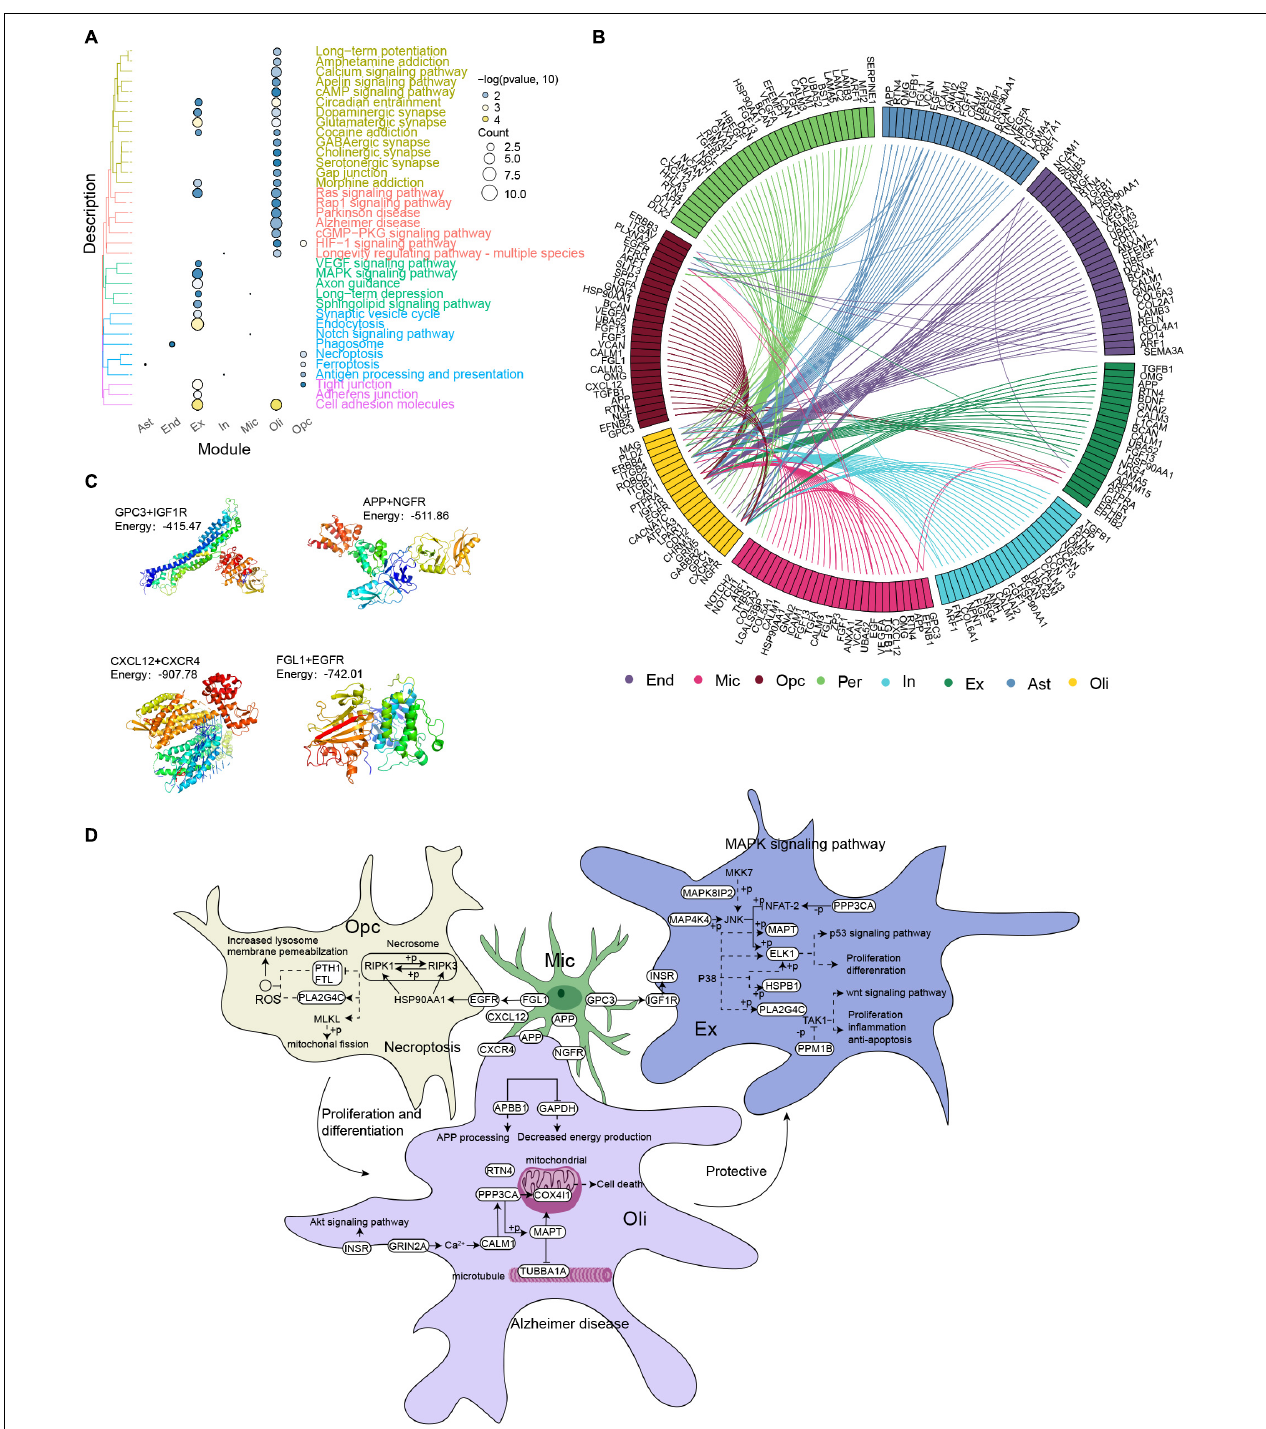
FIGURE 4 | Microglia mediate the occurrence and development of Alzheimer’s disease. (A) Clustering of differentially expressed genes in each cell type according to KEGG pathways. (B) Integrated regulatory network diagram showing interactions between receptors and ligands encoded by pathway genes in AD. (C) Molecular docking between GPC3 and IGF1R, APP and NGFR, CXCL12 and CXCR4, as well as FGL1 and EGFR. Units: kJ per mol. (D) Microglia are postulated to communicate with neurons through the GPC3-IGF1R axis, activating the MAPK signaling pathway, promoting neuronal apoptosis and thus mediating the occurrence and development of AD. Microglia may target oligodendrocytes through the APP-NGFR and CXCL12-CXCR4 axes, activating AD signaling pathways and thereby promoting disease occurrence and development. Microglia may target oligodendrocyte progenitor cells through the FGL1-EGFR axis to activate the necrotic apoptotic pathway, triggering the death of oligodendrocytes and rendering neurons vulnerable to injury. This, in turn, contributes to AD occurrence and development.